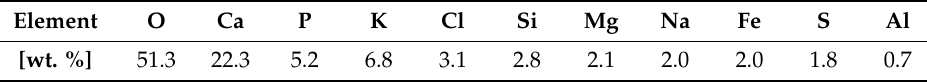
Figure 1. Phase composition of the biomass ash blend after thermal treatment at 900 °C. Table 1. Elemental composition of BM after thermal treatment obtained from Energy Dispersive X-Ray Spectroscopy analysis.